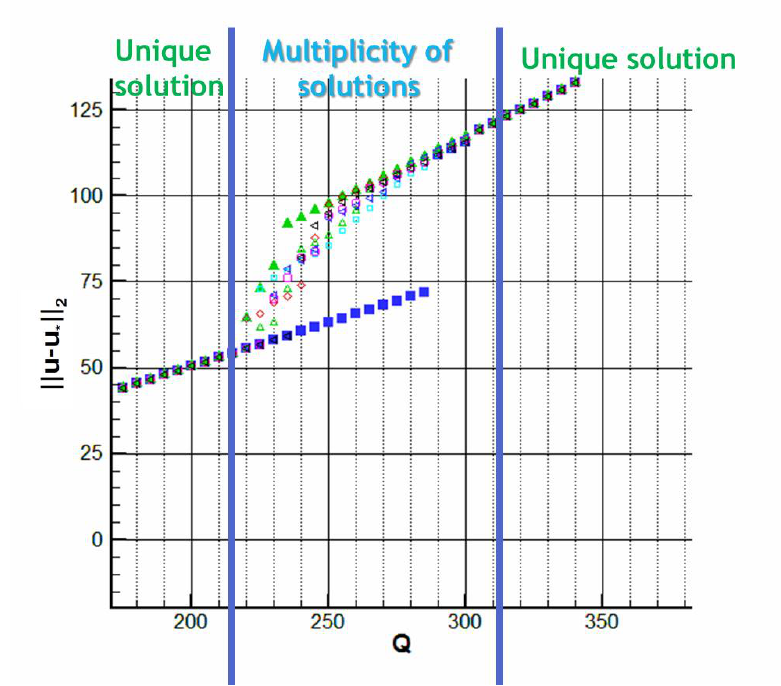
Figure 8. Detail of the Approximated { ( Q , || u − u ∗ || 2 ) } diagram for the coupled